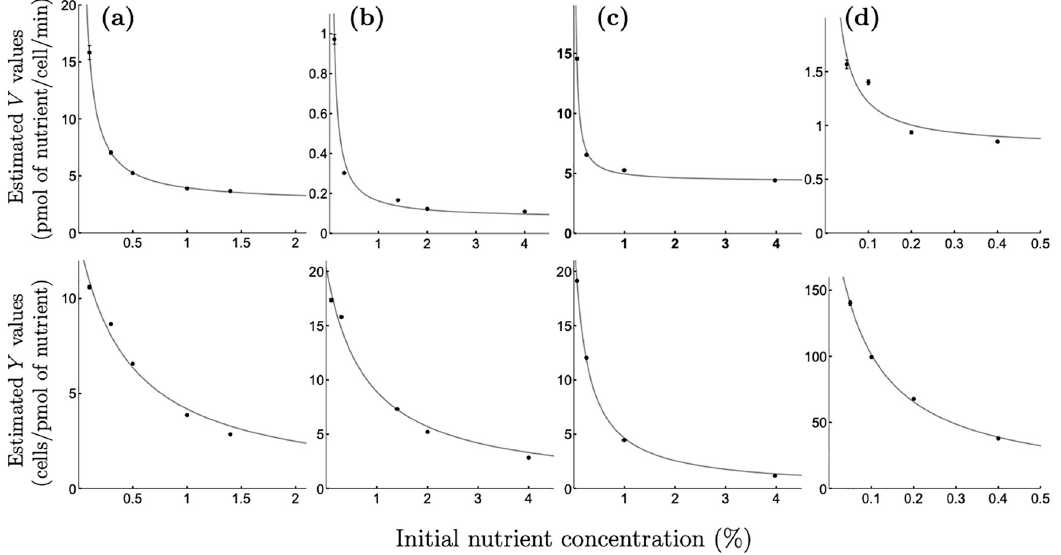
Fig 1. Relationships ‘maximal uptake rate vs initial nutrient concentration’ and ‘biomass yield vs initial nutrient concentration’. Relationships between the maximal uptake rate V and the initial nutrient concentration N 0 (top panels) and between the yield Y and the initial nutrient concentration N 0 (bottom panels) observed for (a) C. albicans growing on glucose; (b) C. glabrata growing on glucose; (c) S. cerevisiae growing on sucrose; (d) E. coli growing on glucose. Dots with error bars (estimated values ± SE, where SE might be obscured by values) represent optimal estimates for parameters V (top panels) and Y (bottom panels) obtained by fitting the model (2) to the experimental data on growth (see S1 Text, Appendix B, B1 Fig—B4 Fig and S1 Text, Appendix A, A1 Table—A4 Table for growth data corresponding to (a)—(d), respectively). Solid lines are the optimal non-linear least-squares fits of the function (8) (top panels) and of the function (3) (bottom panels) to the plotted data. The functional forms of Y ( N 0 ) and V ( N 0 ) are not sensitive to media enrichment or acidification (see S1 Text, Appendix C for details) nor to the addition of the lag-phase growth term into the model (2) (as described in S1 Text, Appendix D).